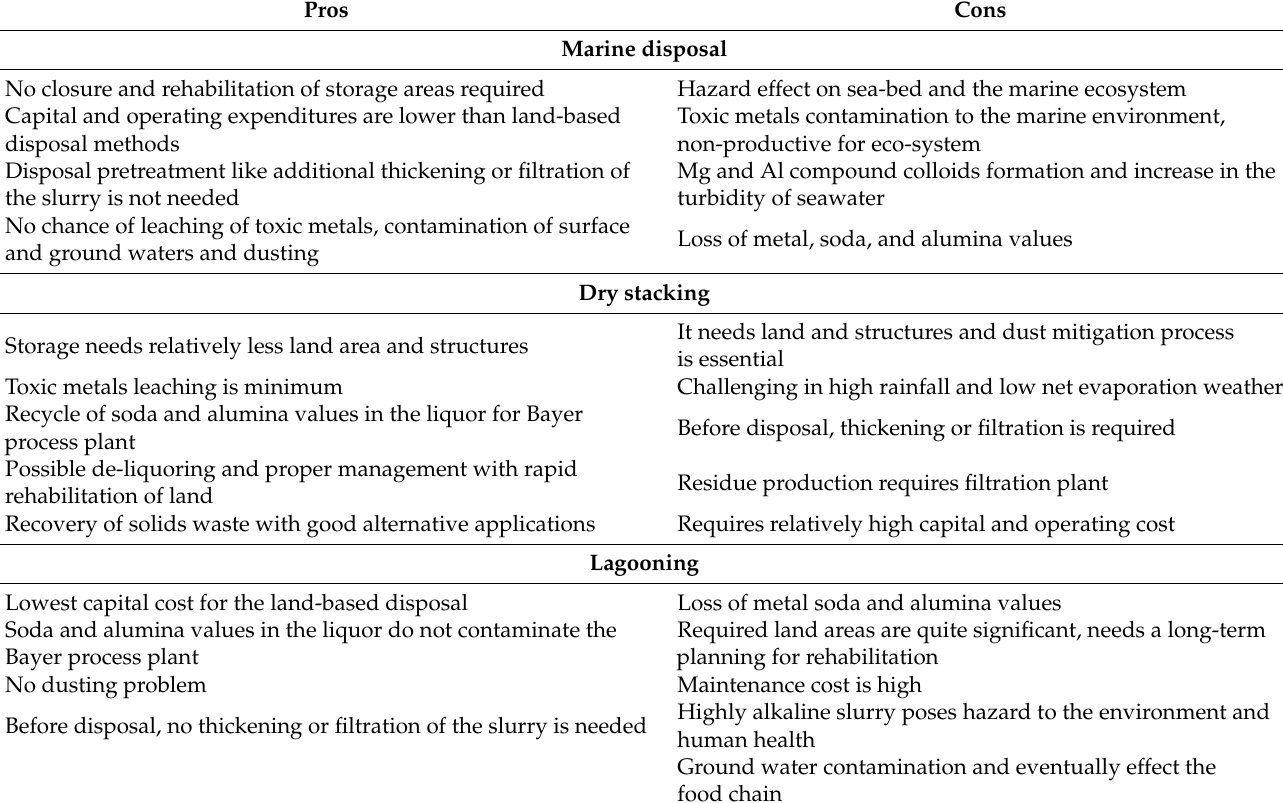
Table 5. Pros and cons of the red mud disposal/management process [61–64]. Pros Cons Marine